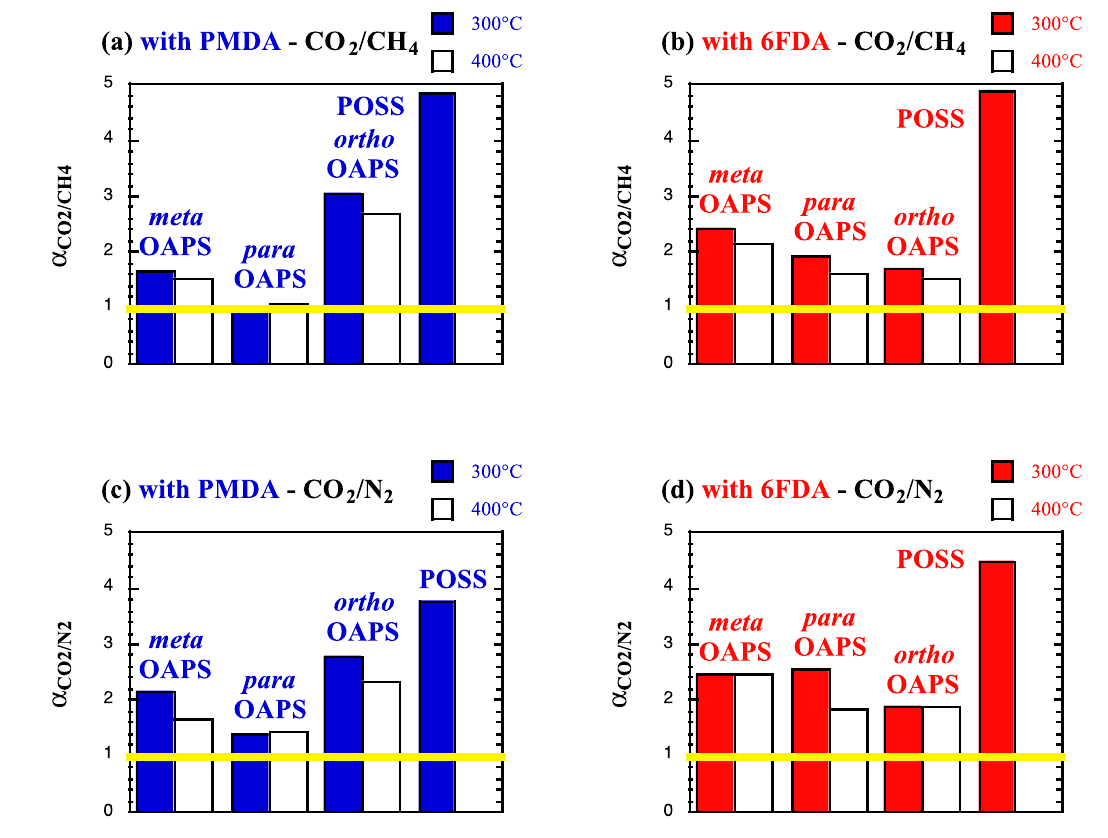
Figure 8. Ideal permselectivities for ( a , b ) CO 2 /CH 4 and ( c , d ) CO 2 /N 2 at 300 ◦ C and 400 ◦ C in the PMDA and 6FDA polyOAPS/POSS-imides calculated from pure feeds at 60 bar. The maximum standard error is 0.2. The yellow lines indicate a α A/B of 1.